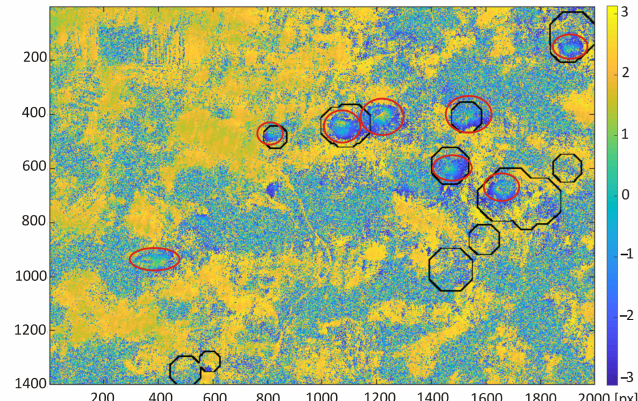
Figure 12. Interferogram of the first area computed from pictures recorded by Sentinel-1 on the 10th and 22nd of October 2016. Red ellipses are the subsidence area marked by experts; black lines were detected by circlet transform.